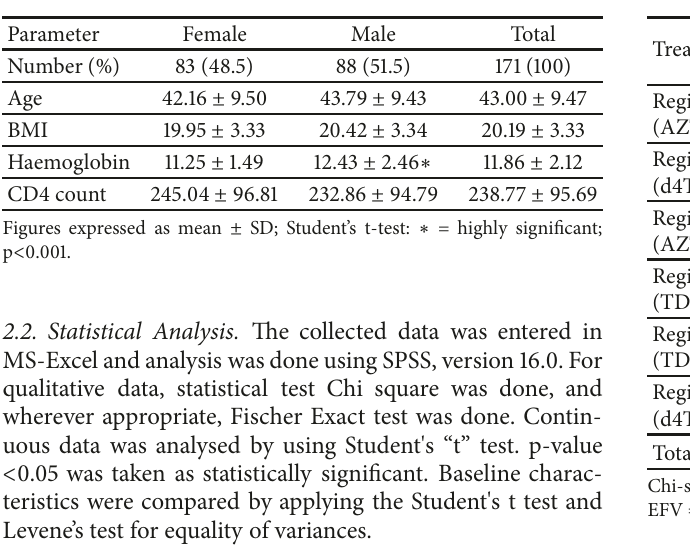
Table 1: Demographic characteristics at baseline. Table 2: Treatment regimens by